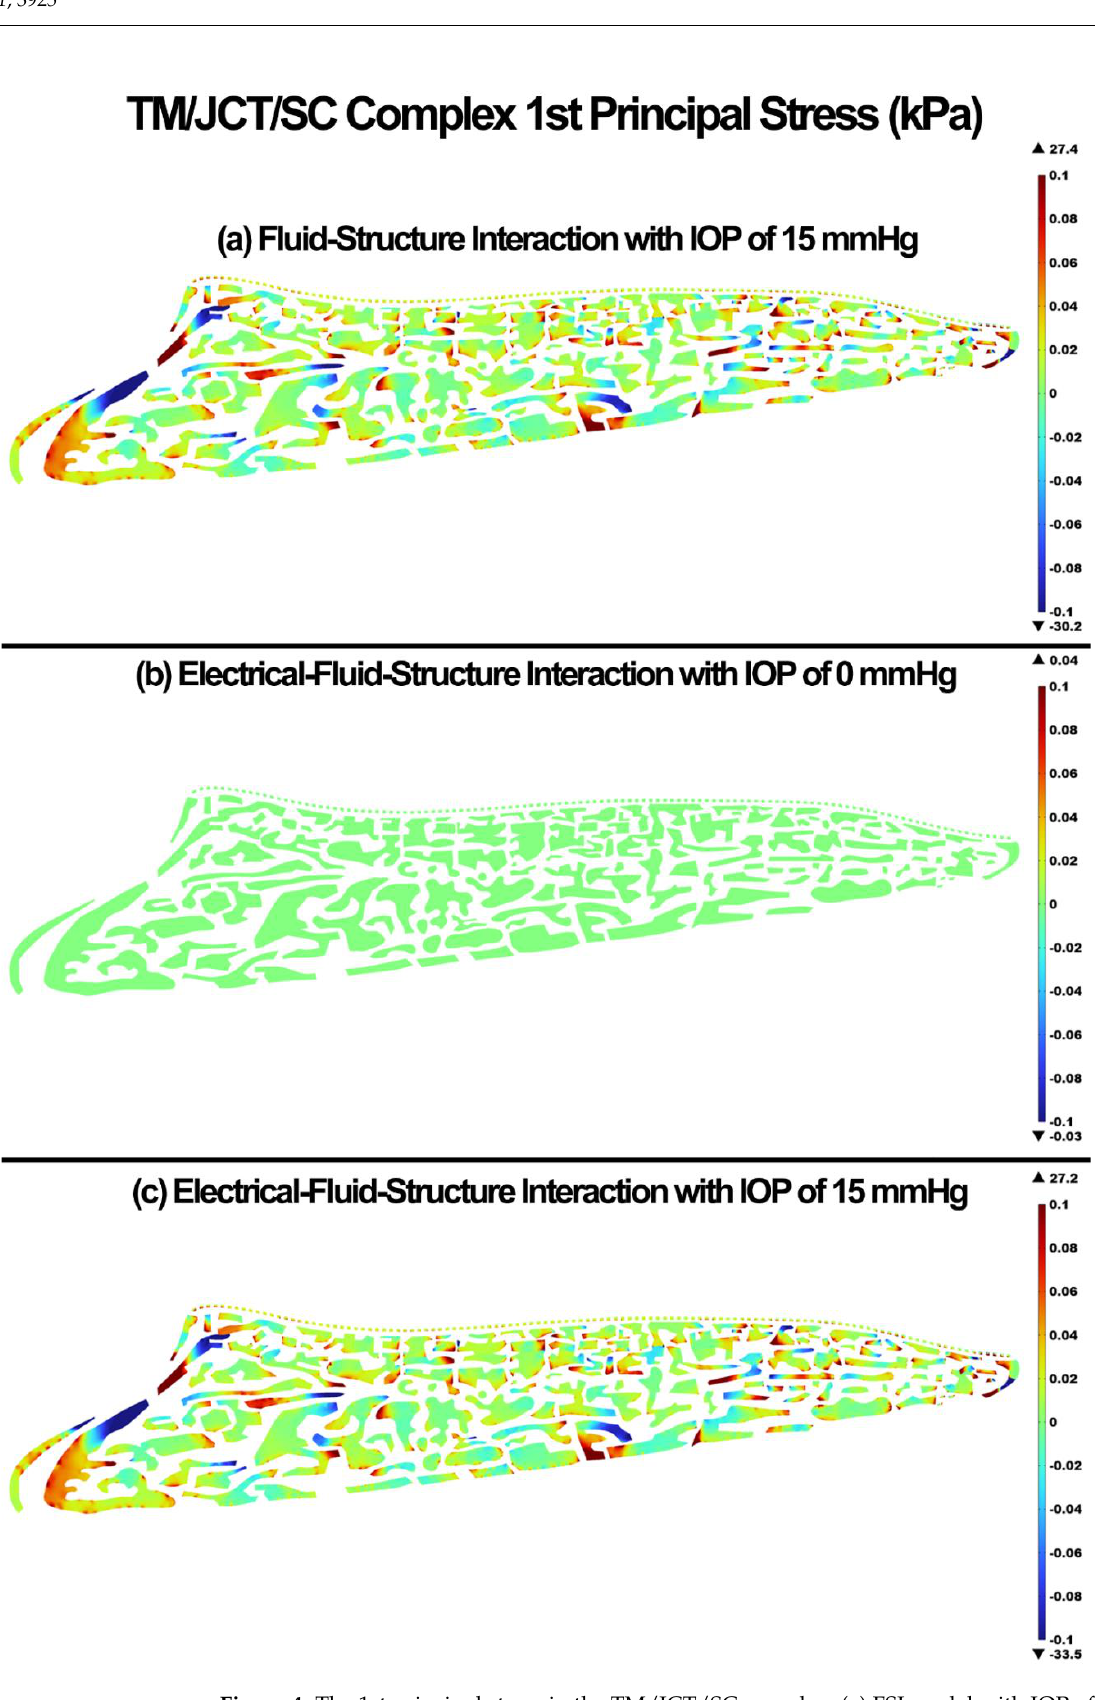
Figure 4. The 1st principal stress in the TM/JCT/SC complex. ( a ) FSI model with IOP of 15 mmHg, ( b ) EFSI with IOP of 0 mmHg, and ( c ) EFSI with IOP of 15 mmHg.